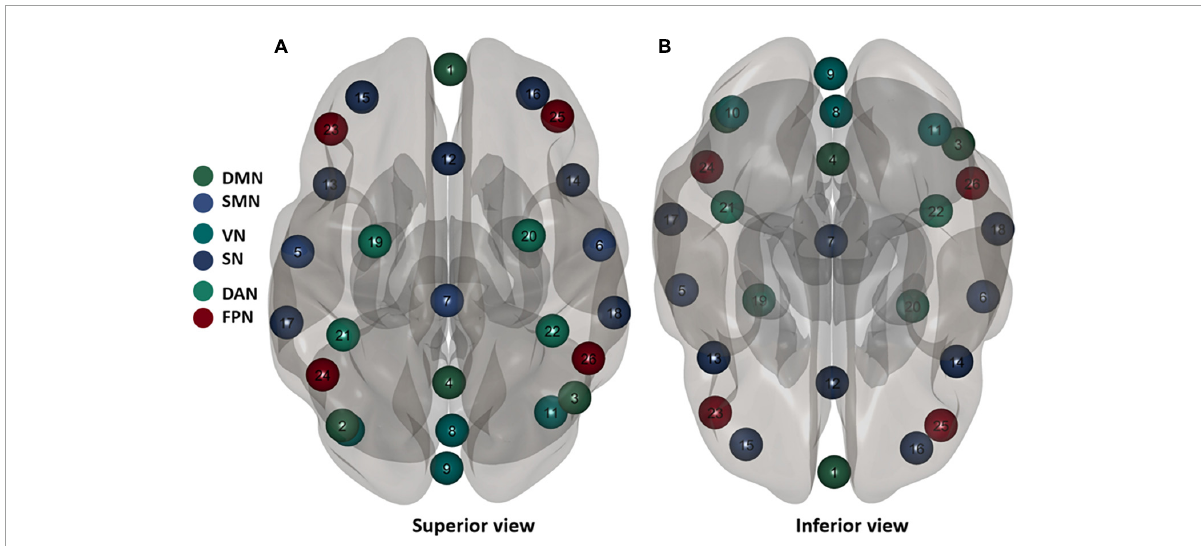
FIGURE4 Twenty six brain regions of interest (ROis) distribution in the brain. Default mode network (DMN), sensorimotor network (SMN), visual network (VN), salience network (SN), dorsal attention network (DAN), ventral attention, and frontal-parietal control network (FPN). These numbers correspond to the number of brain regions in Table 1 .